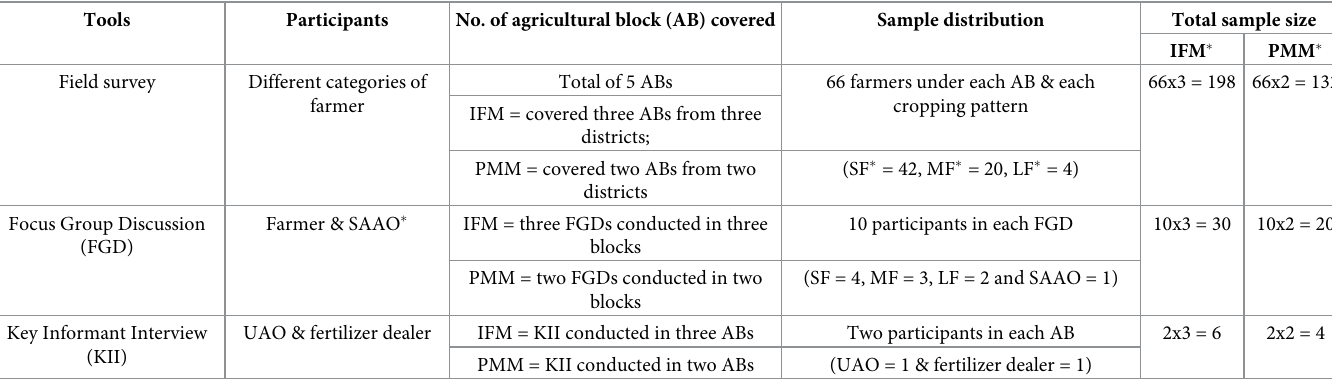
Table 1. Sample design and survey administration of the study.